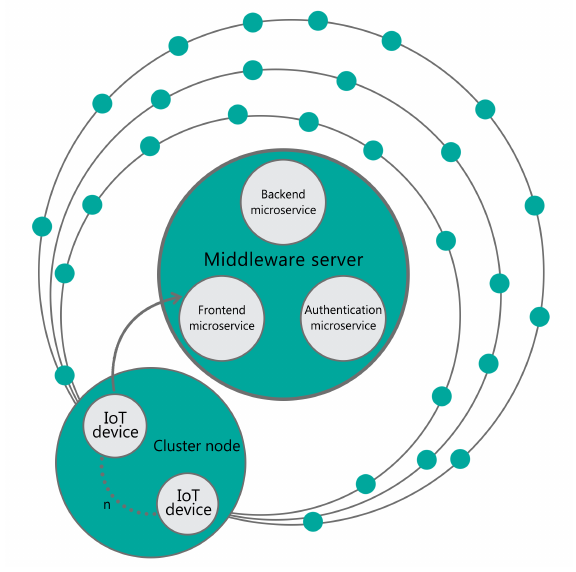
Figure 1. Testbed application